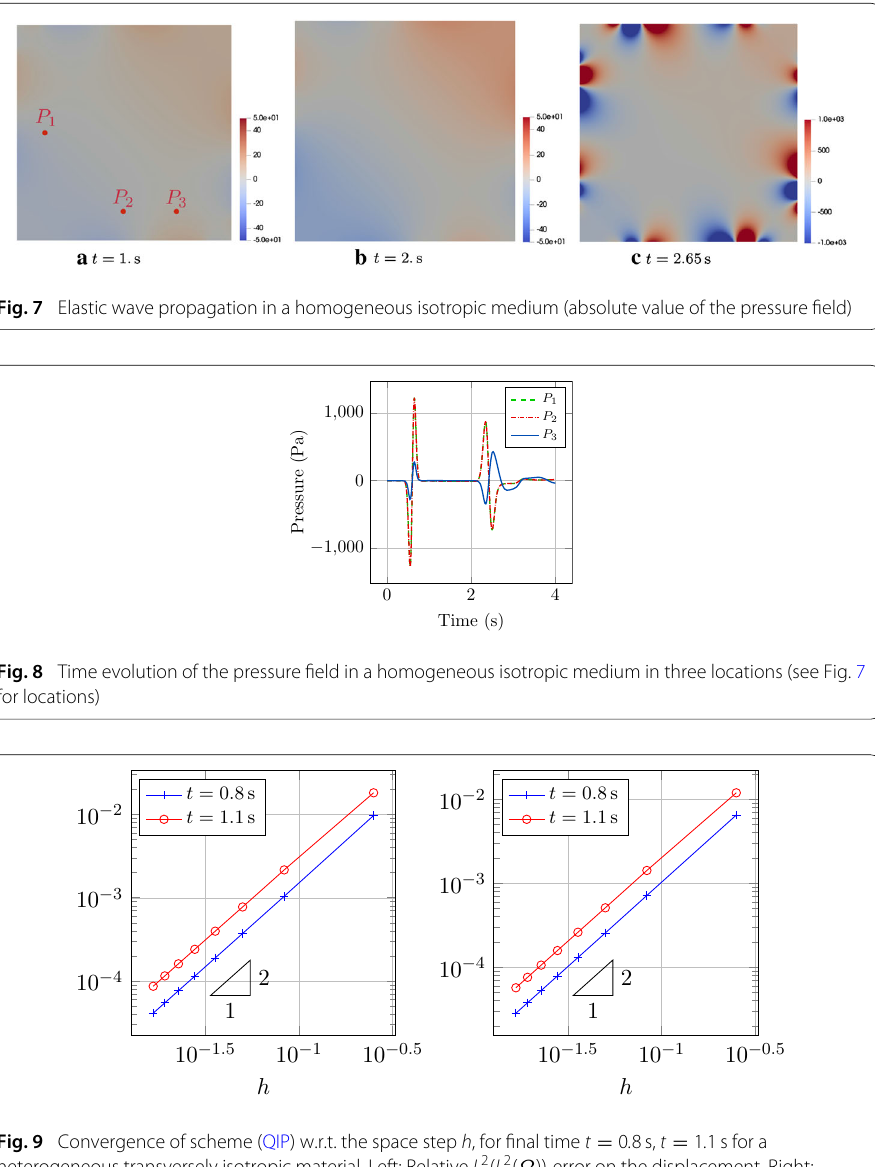
heart wall [49,50]. Moreover, the fibre orientation in human left ventricle myocardium changes linearly throughout the wall thickness, from − 60 ◦ close to the epicardium to + 60 ◦ near the endocardium [51]. In order to model such a material, we consider an orientation of τ 1 varying linearly from − 60 ◦ at the bottom of the domain ( y = 0) to + 60 ◦ at the top of the domain ( y = 1). The resulting medium is highly heterogeneous. Figures 9 and 10 show that the error worsens moderately in transversely isotropic media w.r.t. isotropic media. In addition, the order of convergence remains two for L 2 norm in space, and it is slightly degraded in L 2 ( H 1 ( Ω )) and in L ∞ ( H 1 ( Ω )). Figure 11 illustrates three snapshots at t = 0 . 5 s, t = 0 . 75 s and t = 1 . 1 s of the displace- ment field, respectively. The mesh is composed by N = 40 elements in each direction.